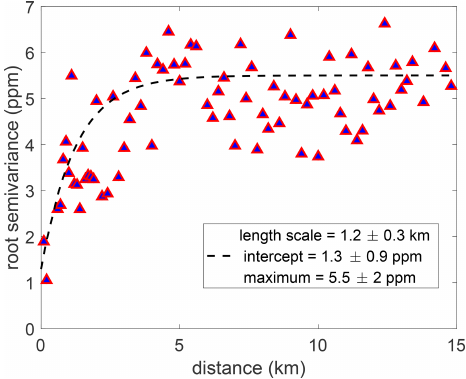
Figure 9. Semivariogram of BEACO 2 N sites for data with temper- ature correction applied. Data are averaged by 0.1km bins. Plot in- cludes data from the Picarro instrument at Richmond Field